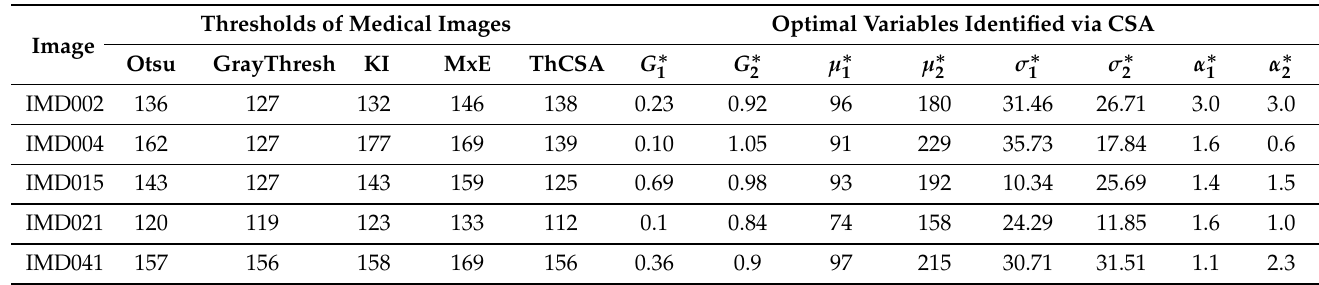
Table 3. Thresholds detected in medical Images with different methods and variables identified by Cuckoo Search Algorithm.